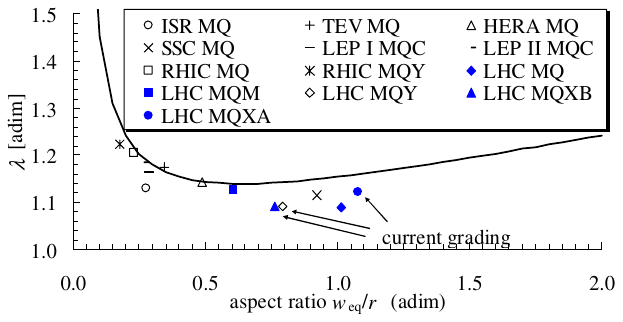
FIG. 25. (Color) Ratio (cid:8) between peak field and current density vs aspect ratio as defined in Eq. (41): computation for a sector coil (solid line) and values for 13 quadrupoles evaluated without iron